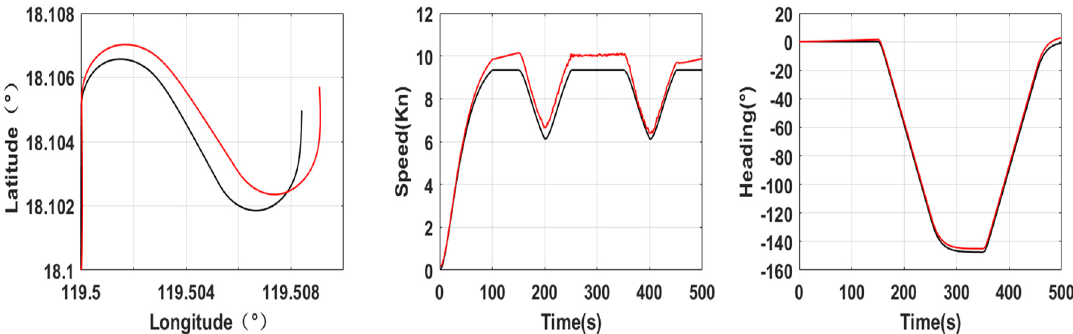
Figure 10. Comparison of simulation data without and with